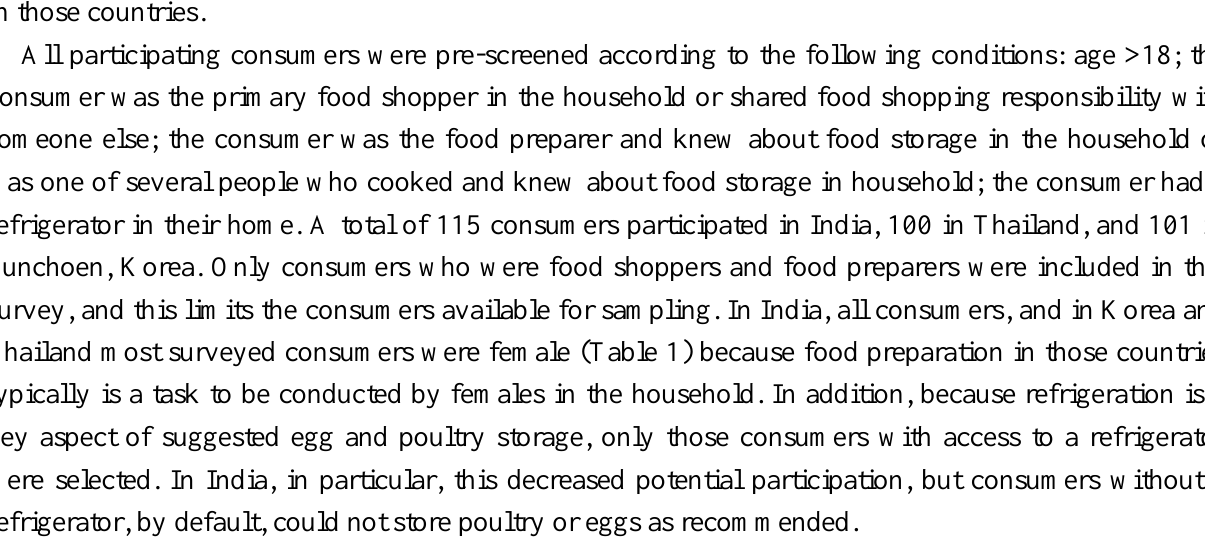
Table 1. Demographic characteristics of the surveyed